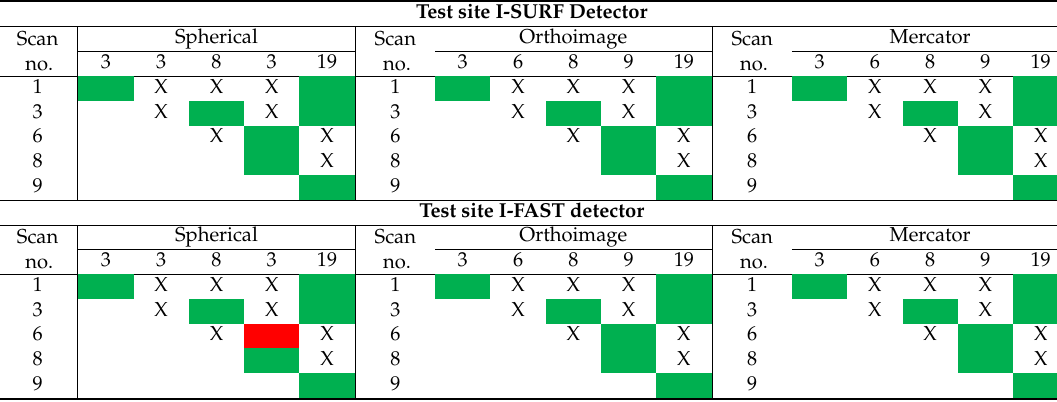
Table 6. The correctness of automated connecting of scans for Test Site II (both scenarios): Green, correct matching (full-registration), orange, preliminary orientation requiring the final registration using the ICP method, red, no matching, and "x", means not connection for scans (no overlap).